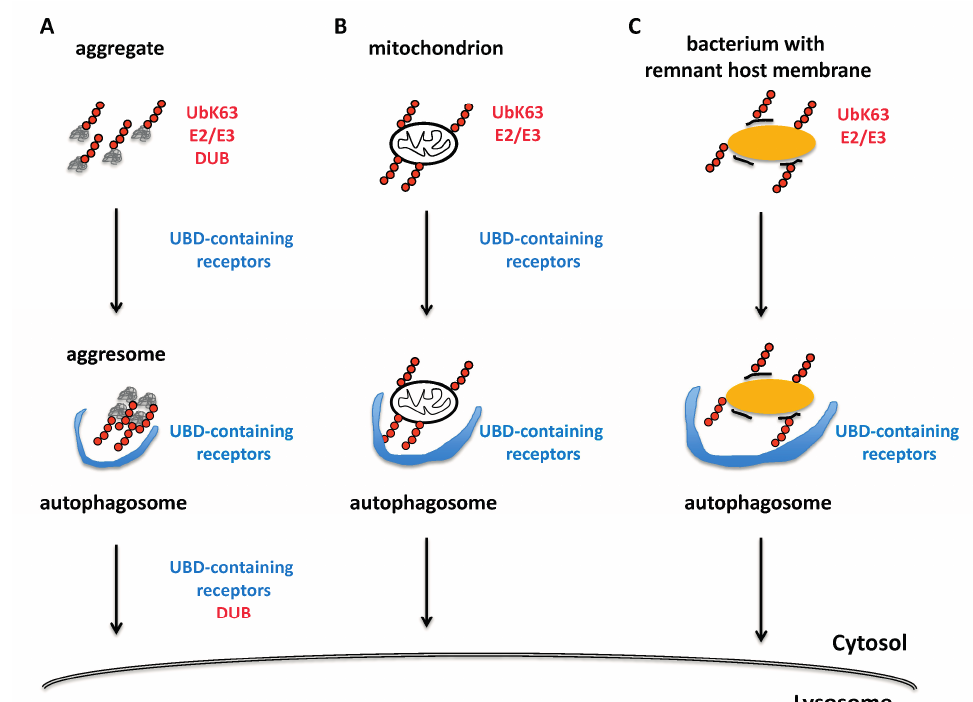
Figure 3. Involvement of UbK63 chains in selective